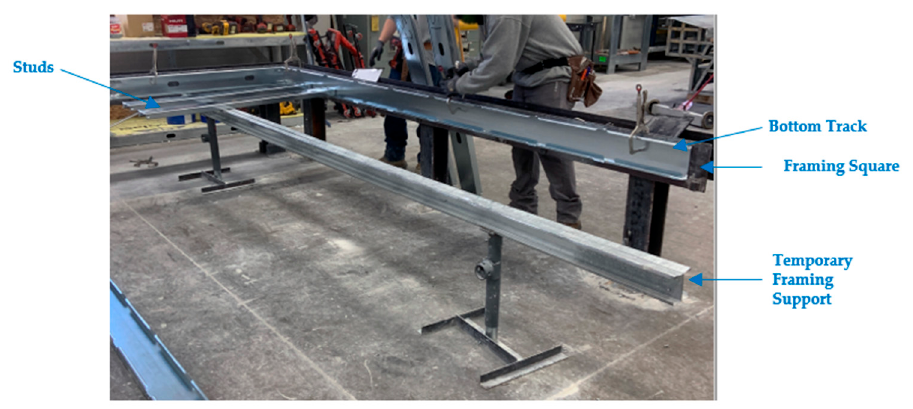
Figure 7. Wall panel assembly in plant.